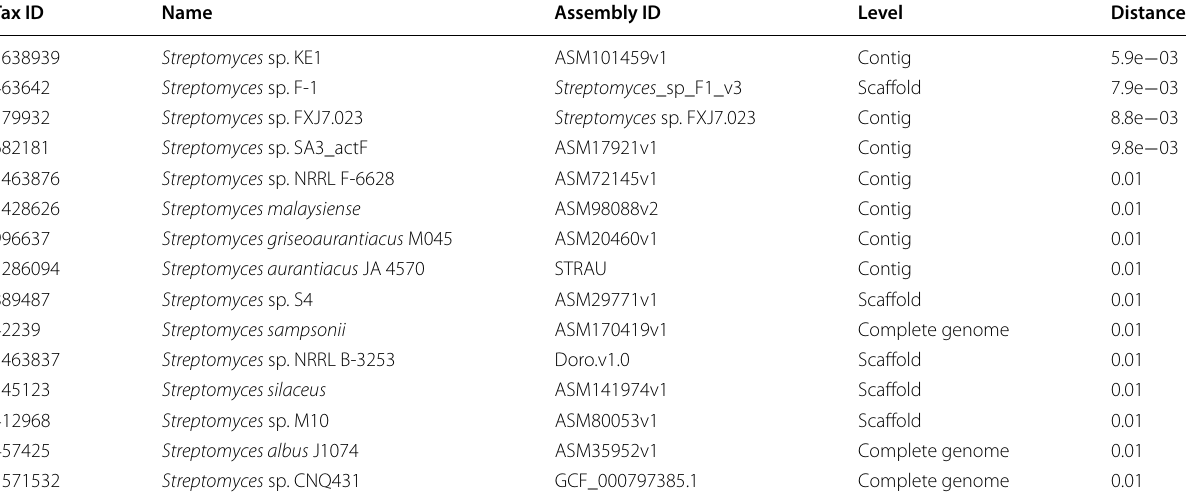
Table 1 List of strains closely related to Streptomyces diastaticus CS1801 Tax